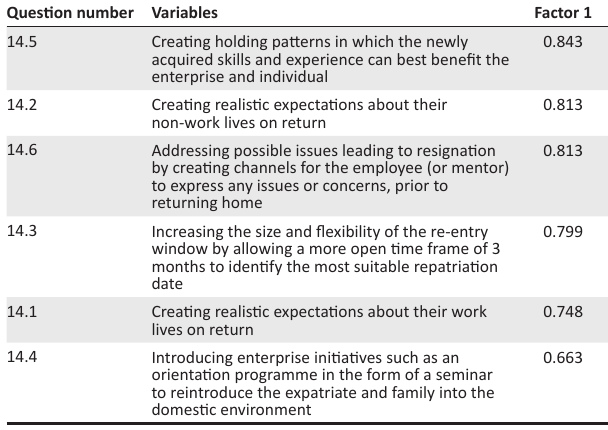
TABLE 6: Factor matrix with sorted rotated factor loadings.